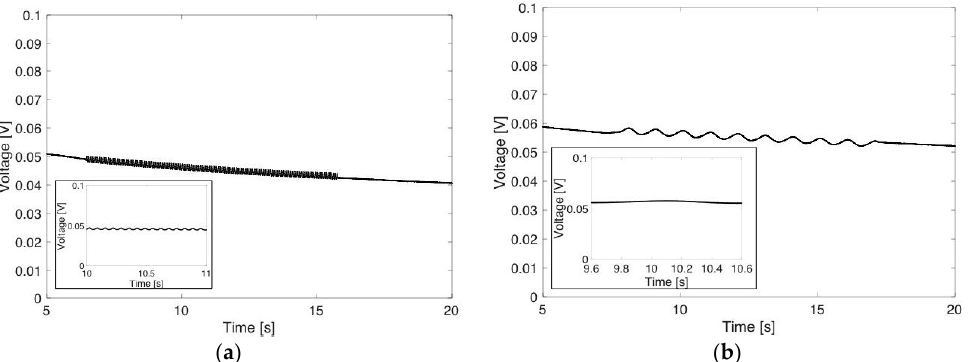
Figure 13. DC voltage responds to tensile loading and unloading cycles applied to FS-1P7L from 0% to 1% at ( a ) 1 Hz and ( b ) 15 Hz. Inset plots show the DC voltage response for 1 s time duration.